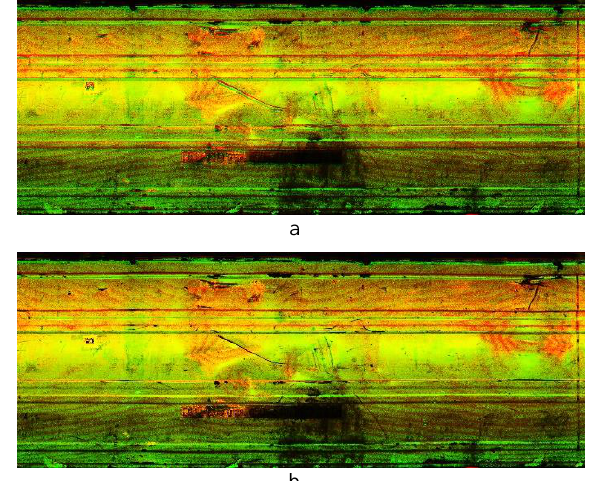
to grayscale as the red channel, Range Intensity as the green application of the thin-plate-spline-interpolation based transformation.